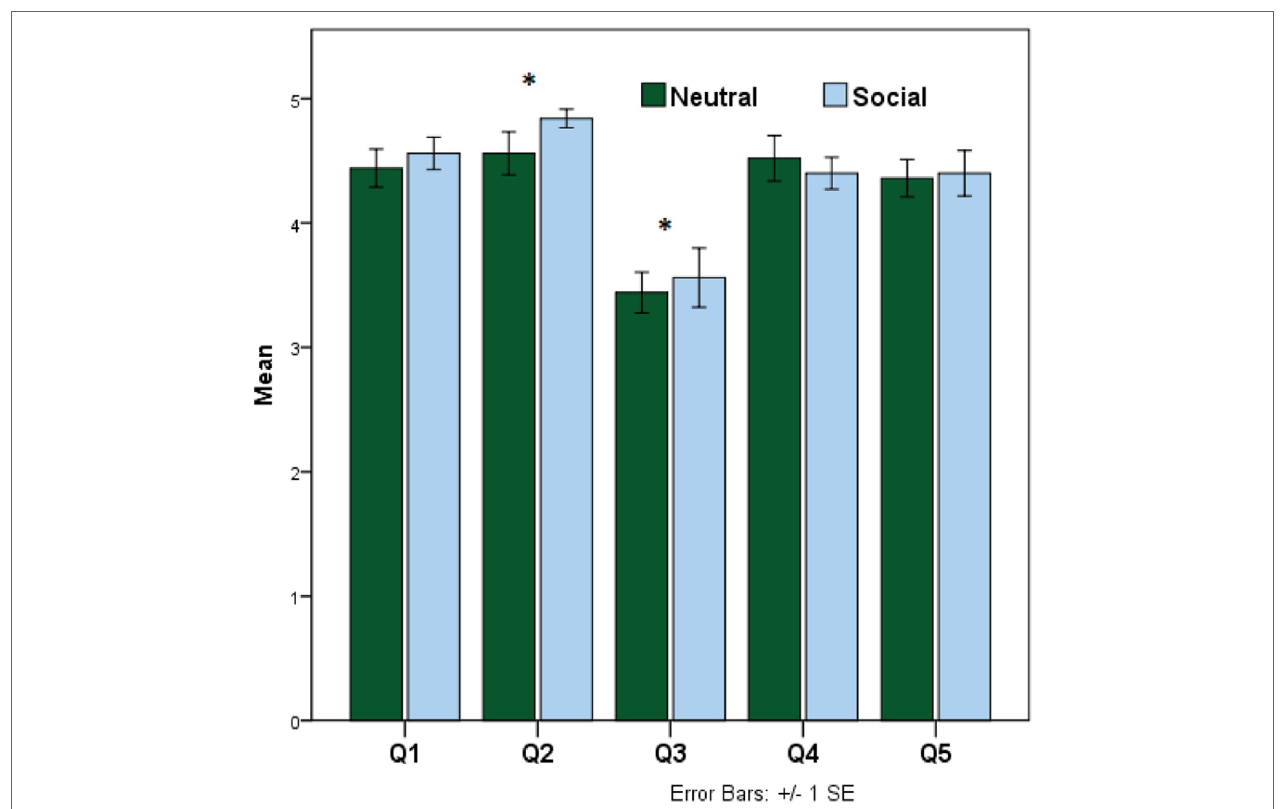
FigUre 8 | Recharging questions graph, N = 50, α = 0.82, bars represent mean